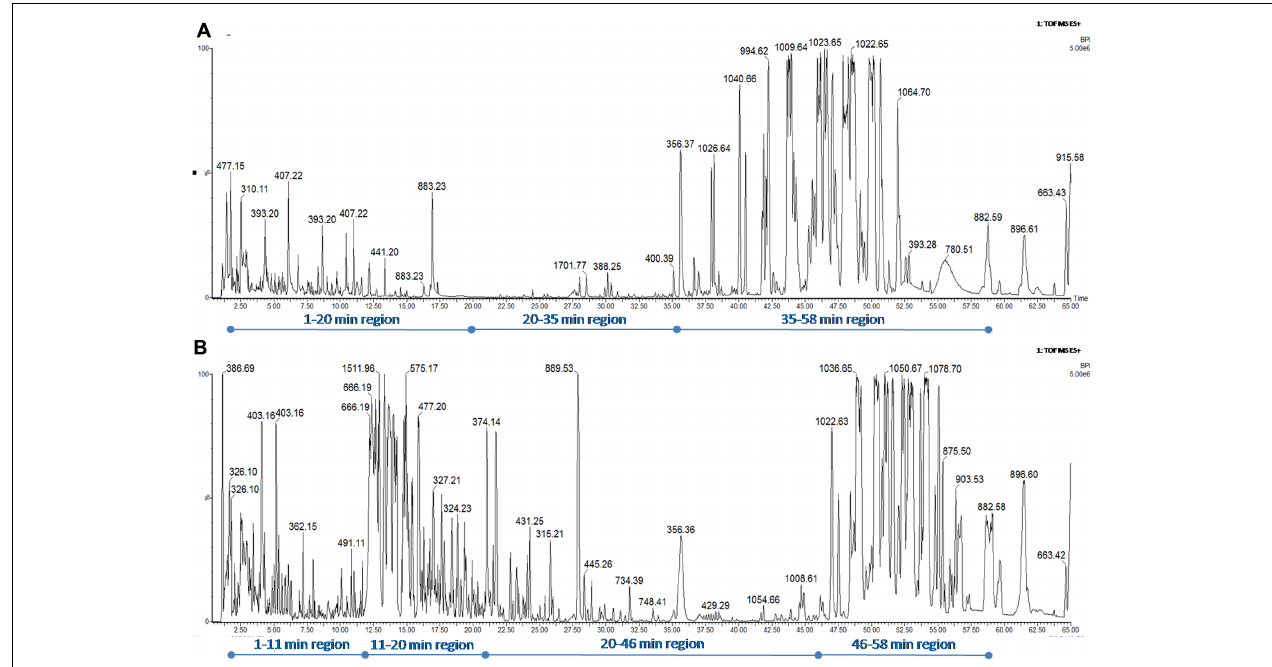
FIGURE 3 | Base-peak intensity-chromatogram (BPI) of CFS issued from the B. subtilis 23 COPS (A) and B. pumilus 35R (B) strains. The BPI-chromatograms are normalized to 5 × 10 6 ions for a better BPI-chromatogram comparison. Elution of the C18-retained molecules were performed using a linear ACN gradient of around 1.3%/min (25–95% ACN in 55 min).